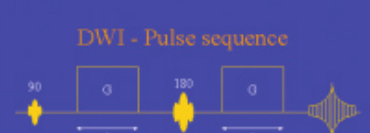
Fig. 1b. Axial ‘DWI’ with b value = 0 which is in reality a T2WI, the initial series of a diffu- sion-weighted sequence.